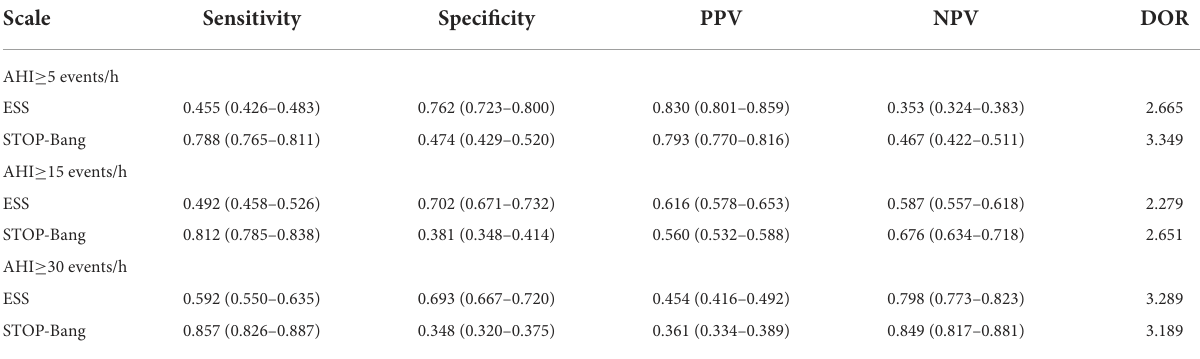
TABLE 3 The scale predictors of each group patients [percentage